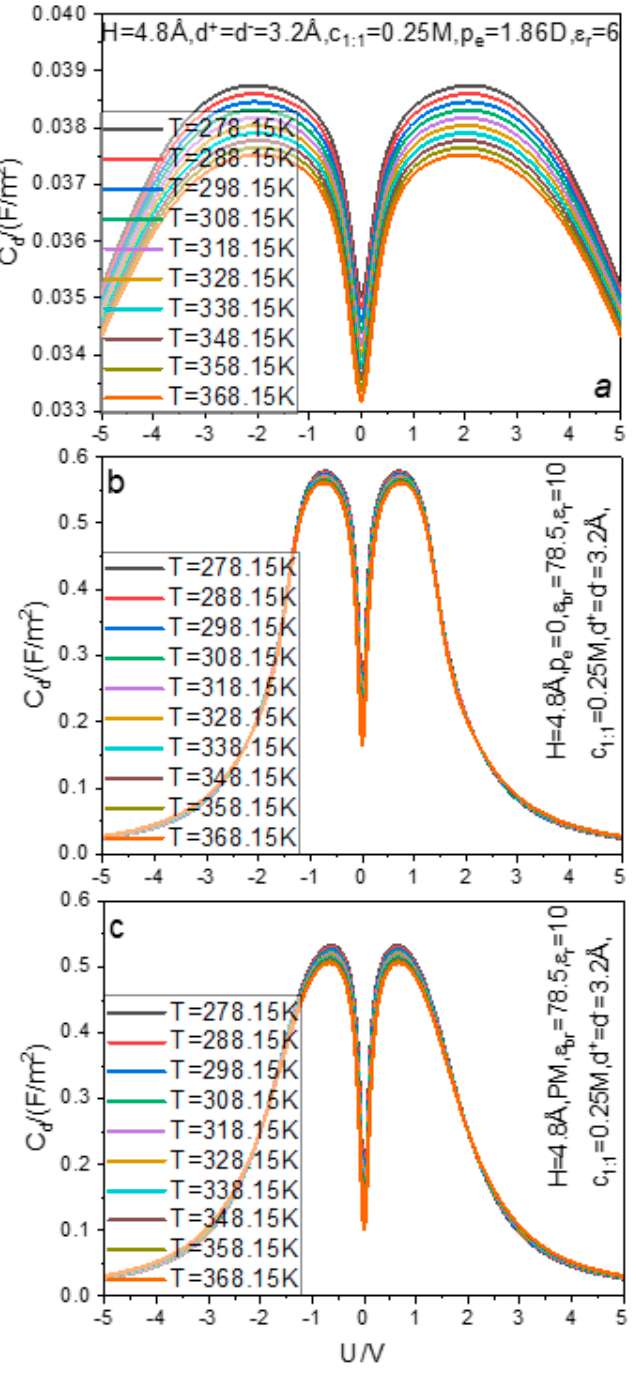
Figure 3. Correlation between the temperature T and differential capacitance–voltage curves ( a – c ).